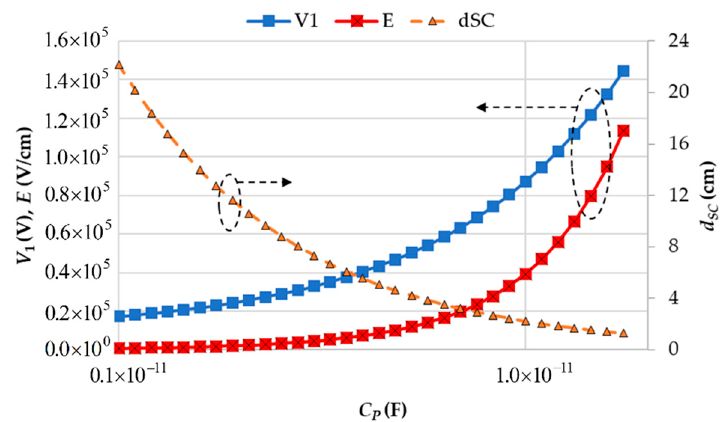
Figure 16. Stress voltage and EF level behavior over parasitic capacitance and gap variations.